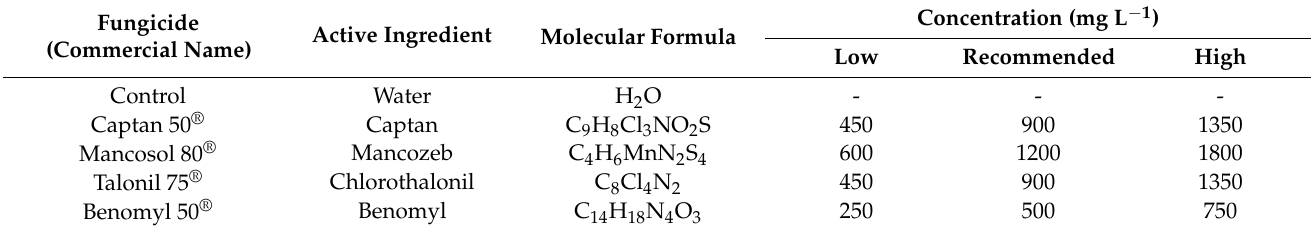
Table 2. Fungicides at different concentrations